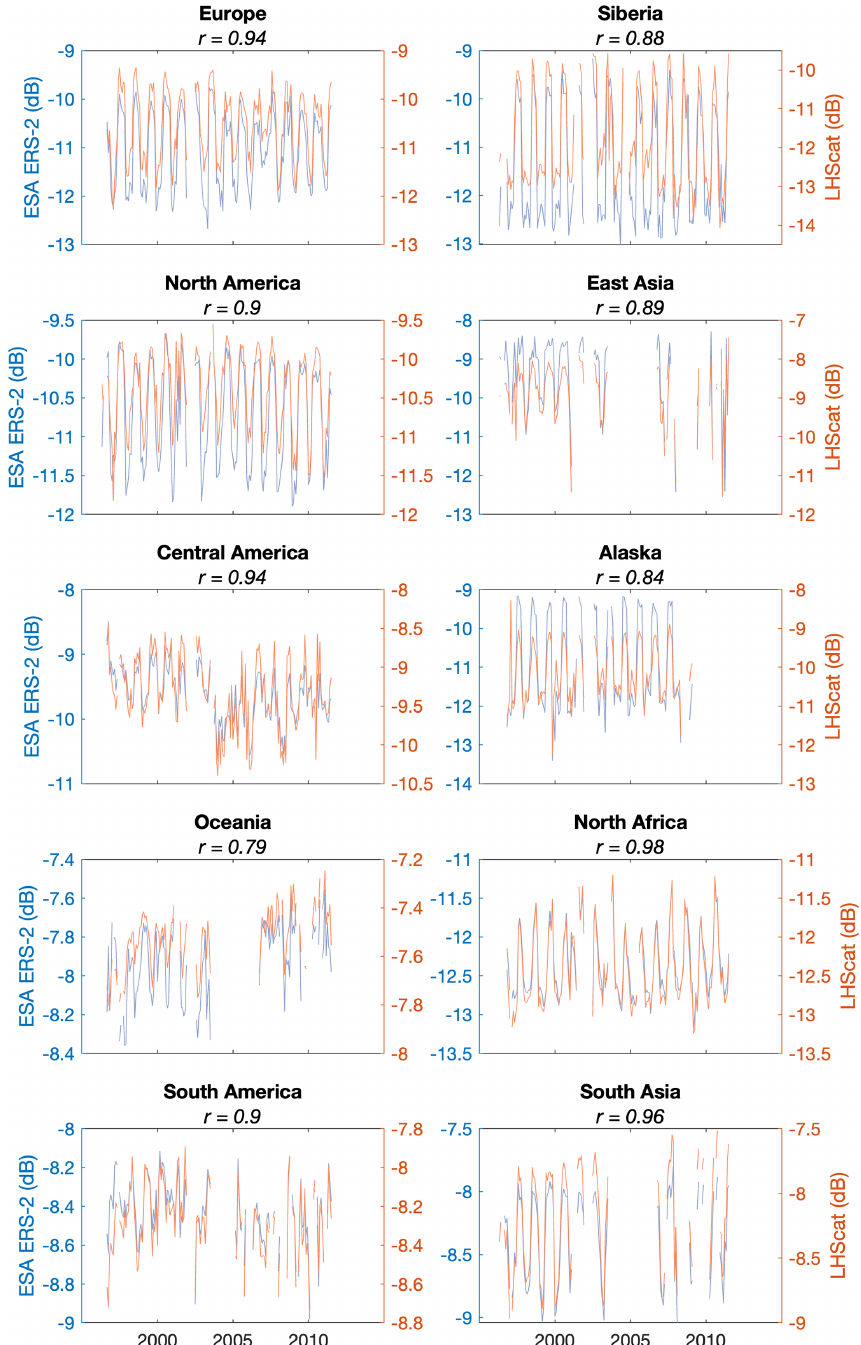
Figure 9. Validation of the merged LHScat radar signals against the ESA ERS-2 data. Note that LHScat values are different from ESA ERS-2 values because the LHScat signals have been rescaled, taking ASCAT as the baseline.